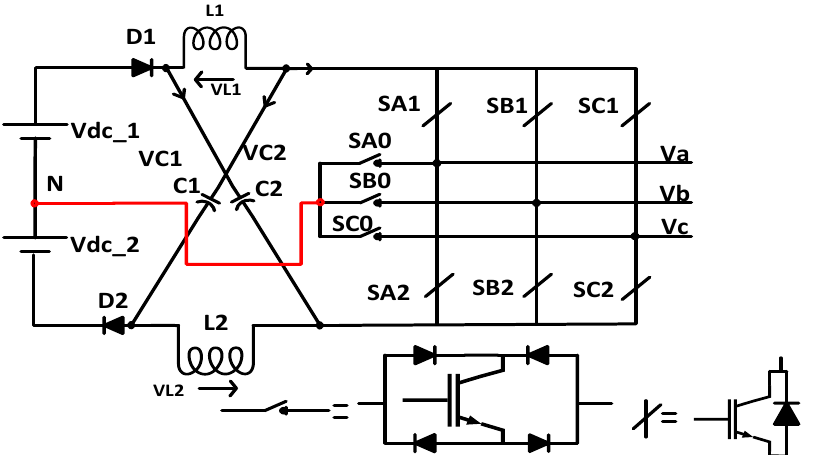
Figure 7. Three-level TC-ZSI using two impedance networks.